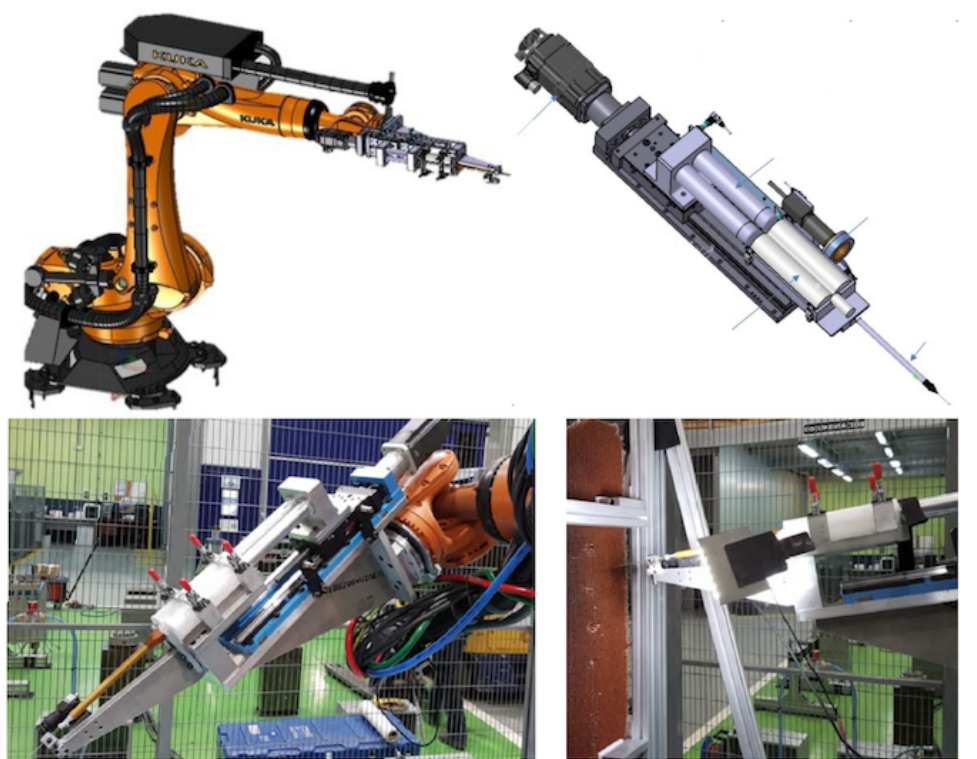
Figure 6. The prototype of the single-cell injector. Upper panels : Design of the injector group mounted on the linear actuator stage and end-effector mounted on the robotic arm. Lower panels : Injection group mounted on a rigid frame fastened to the robot wrist. The injection pipe is supported for rigid guiding. Test for filling the cells of a honeycomb